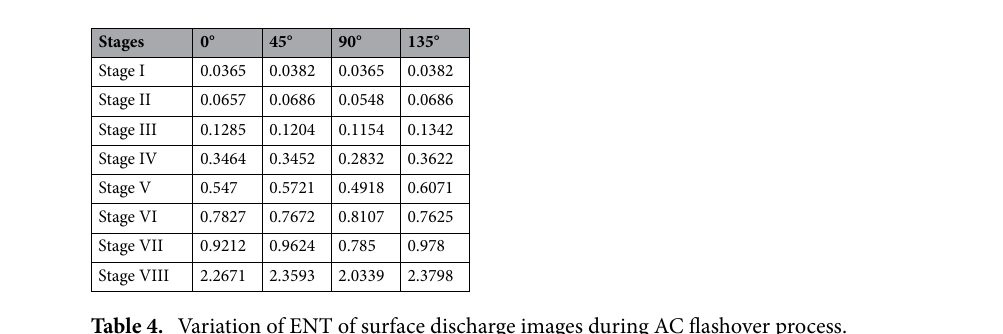
Table 4. Variation of ENT of surface discharge images during AC flashover